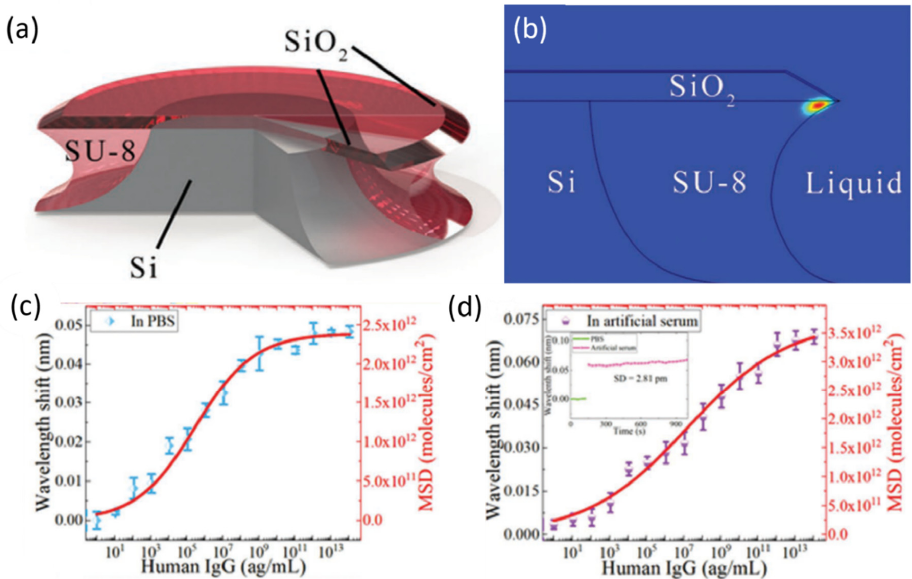
Figure 22. ( a ) HD structure. ( b ) mode field location based on simulations. ( c ) Shift in spectrum with human IgG in PBS. ( d ) Shift in spectra for human IgG in artificial serum. Reproduced from ref. [116] with permission from John Wiley and Sons.